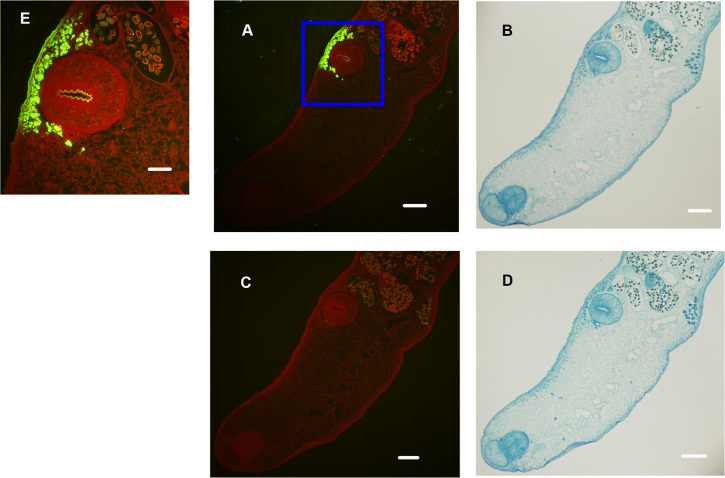
Immunolocalization of Cs1 in adult C. sinensis.Fluorescence microscopy images (left) and corresponding optical images (right) of adult worms are shown. Cs1 localization is represented in (A) and (B) and the negative controls are shown in (C) and (D). (E) is 2.5 times the magnification of the boxed area in (A). Scale bar equals 500 μm in (A)-(D) and 250 μm in (E).